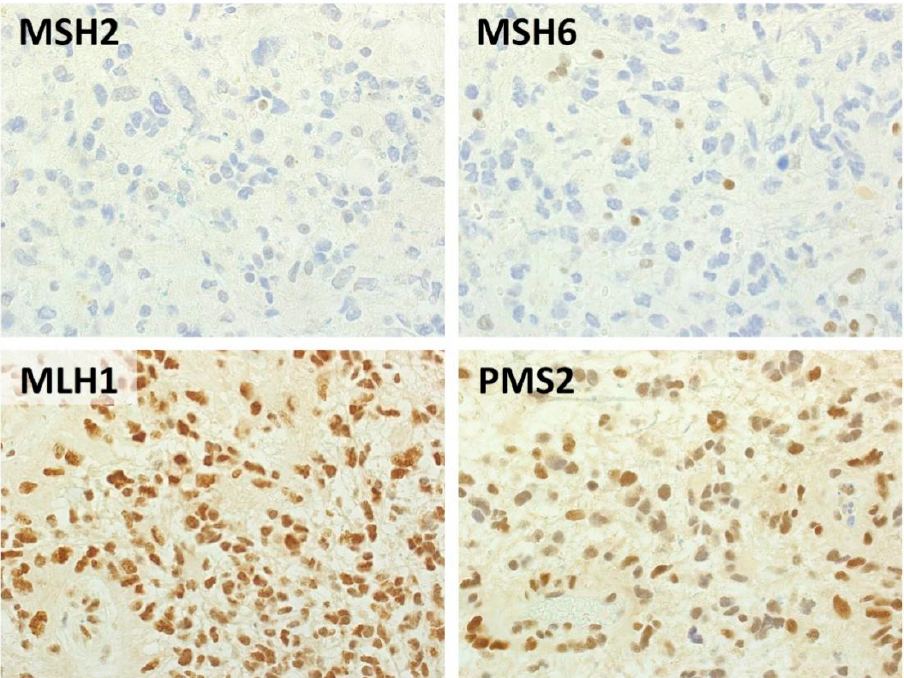
Figure 1. Representative histological features of a MSH2/MSH6-negative glioblastoma. Immunohistochemical analysis highlighted negativity for MSH2 and MSH6 in neoplastic cells, with preserved expression of MLH1 and PMS2. Background inflammatory cells were used as positive internal controls. (Immunoperoxidase stain, original magnification 40×).